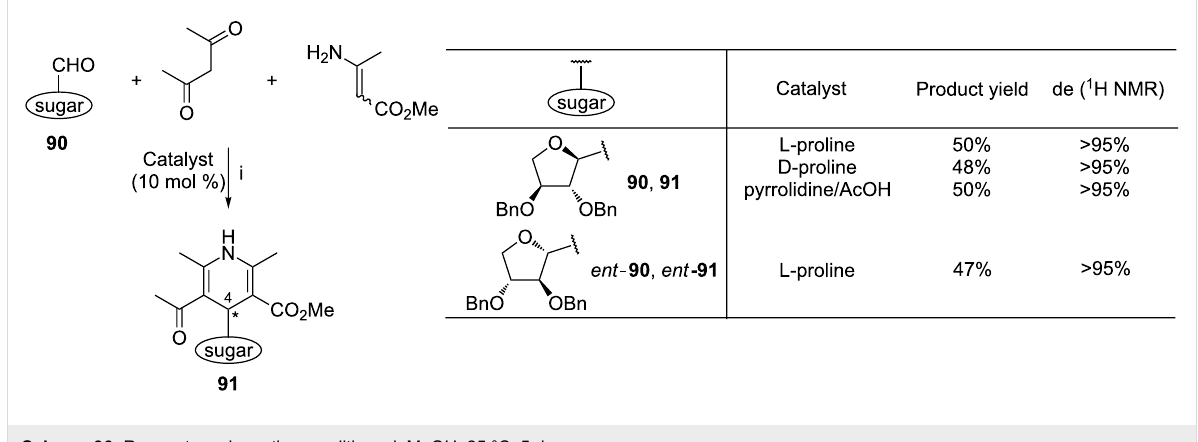
Scheme 36: Reagents and reaction conditions: i. MeOH, 25 °C, 5 d.